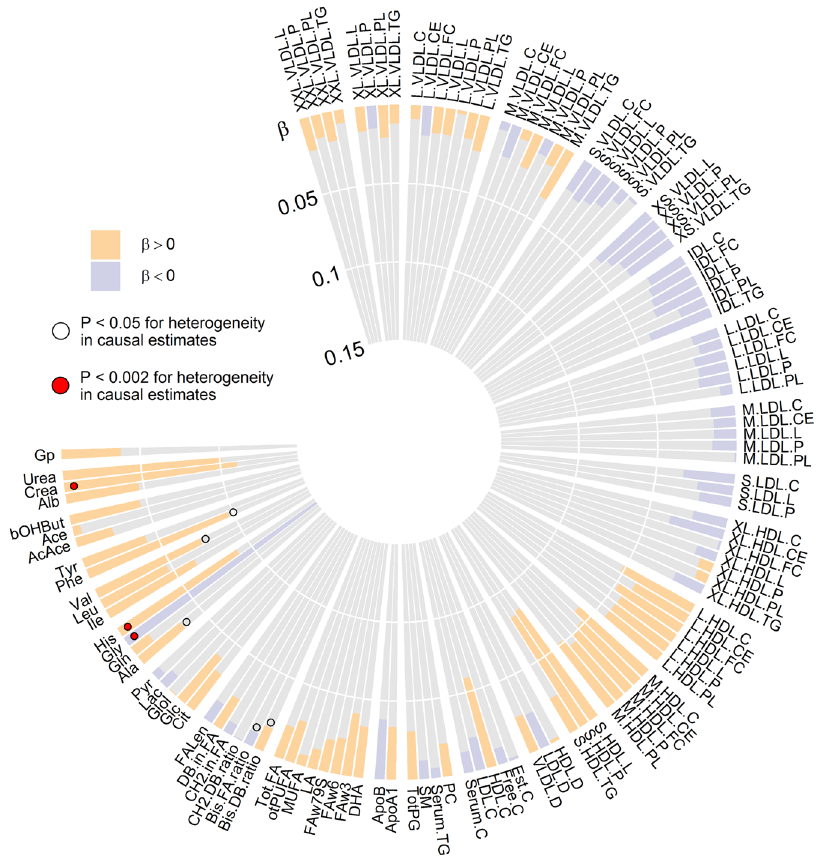
Figure 5. Combined causal effect estimates ( β = beta; coloured bars indicate the direction and magnitude of the effect; yellow bars, β > 0, blue bars, β < 0) of hArg with 122 systemic metabolic measures using summary-level data from previous meta-analyses of genome-wide association studies. For each metabolite, the summary-level data across the three hArg associated SNPs ( GATM rs1153858, CPS1 rs1047891 and AGXT2 rs37369) was combined using weighted linear regression, and the heterogeneity in the causal effects from different individual variants was tested by Cochran’s Q statistic. All p-values for combined causal effects > 0.05. A p-value of > 0.05 from Cochran’s Q statistic indicates that there is no more heterogeneity between causal effects estimated using the variants individually than would be expected by chance. The numbers of individuals used to estimate SNP– metabolite associations vary between 8 905 and 24 924, depending on the